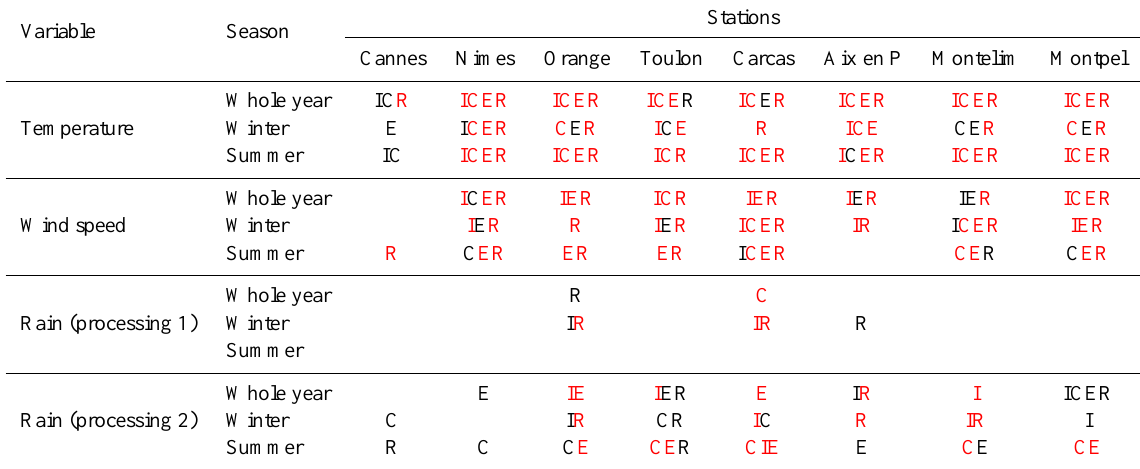
Table 3. For each station, variable, and period of the year, the letters indicate the large-scale data (I=IPSL, C=CNRM, E=ECHAM5, R=ERA-40) which provide downscaled CDFs considered by the KS-test as similar to the observations for the validation period with a 80% confidence level (90% confidence level in